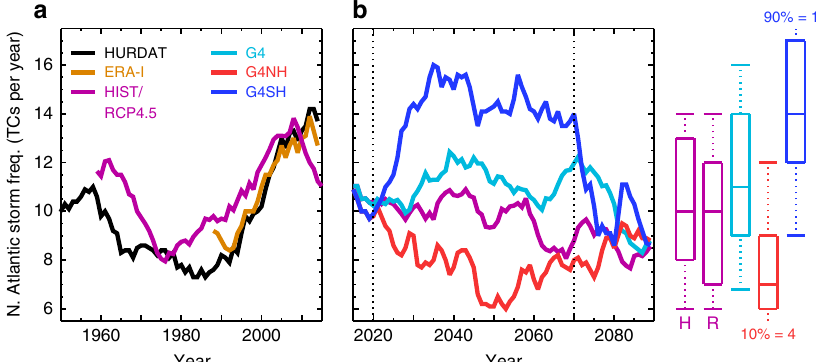
Fig. 4 Observed and simulated Tropical cyclone frequency. a Historical tropical cyclone (TC) frequencies, smoothed by a 10-year simple moving average, for ERA-I 28 , the ensemble mean of the HadGEM2-ES HIST simulations and HURDAT2 observations 29 . b The same as a but for the RCP4.5 and SAI simulations. The box and whisker plots (right) show the 10, 25, 50, 75 and 90% quantiles of the HIST ( ‘ H ’ , 1950 – 2000), RCP4.5 ( ‘ R ’ , 2020 – 2070) and SAI (2020 – 2070) raw annual TC frequency. G4 refers to a global SAI scenario, G4NH refers to a northern hemisphere SAI scenario, and G4SH refers to a southern hemisphere SAI scenario. Vertical dotted lines at years 2020 and 2070 ( b ) indicate the start and cessation of solar geoengineering,